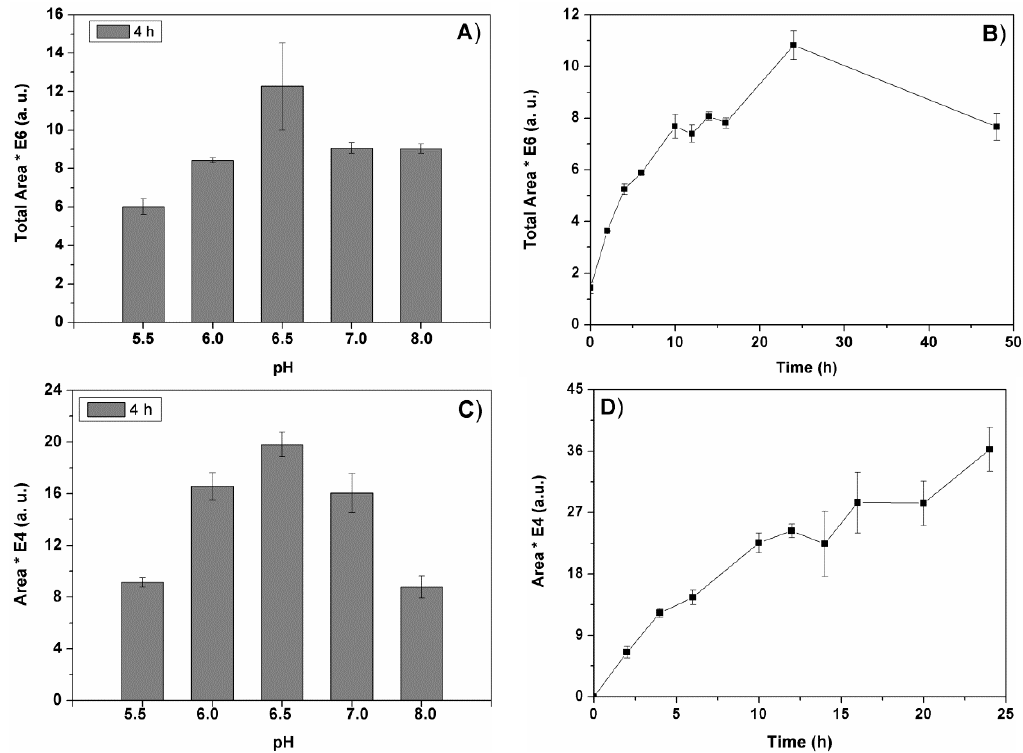
Figure 1. Enzyme-assisted extraction with Alcalase ® of the polar spirulina biocomponents. Variations of total peak area in the HPLC-ELSD analyses: ( a ) effect of pH on the total area of peak products extracted at 4 h of enzyme treatment. ( b ) Time course of the extraction at optimal pH 6.5, for the total peak area. ( c ) Variation of the area value of the peak at 67.83 min retention time, for 4 h of enzyme treatment. ( d ) Time course of the extraction at optimal pH 6.5, for the peak at 5.5 min retention time. Other conditions: 1% (v/w) enzyme loading and 40 °C. A.U.: arbitrary area units.